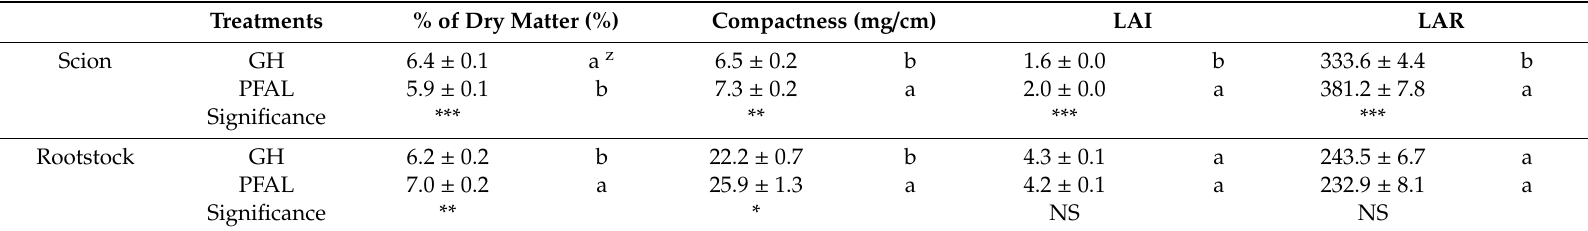
Table 6. The percentage of dry matter, compactness, leaf area index (LAI) and leaf area ratio (LAR) of cucumber scion and rootstock cultivated in a PFAL and GH ( n = 7, R =